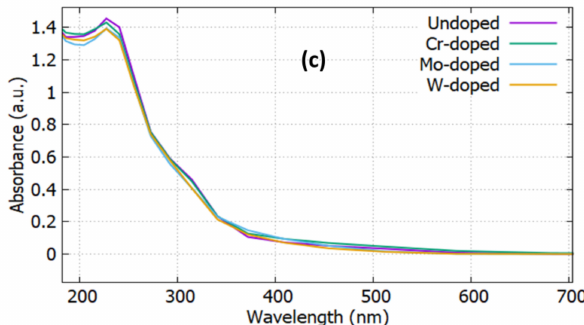
Figure 5. The absorption graph for all the doping cases ( a ) for all the spectrum ( b ) for the visible region (1.78–3.1 eV) and ( c ) as a function of the